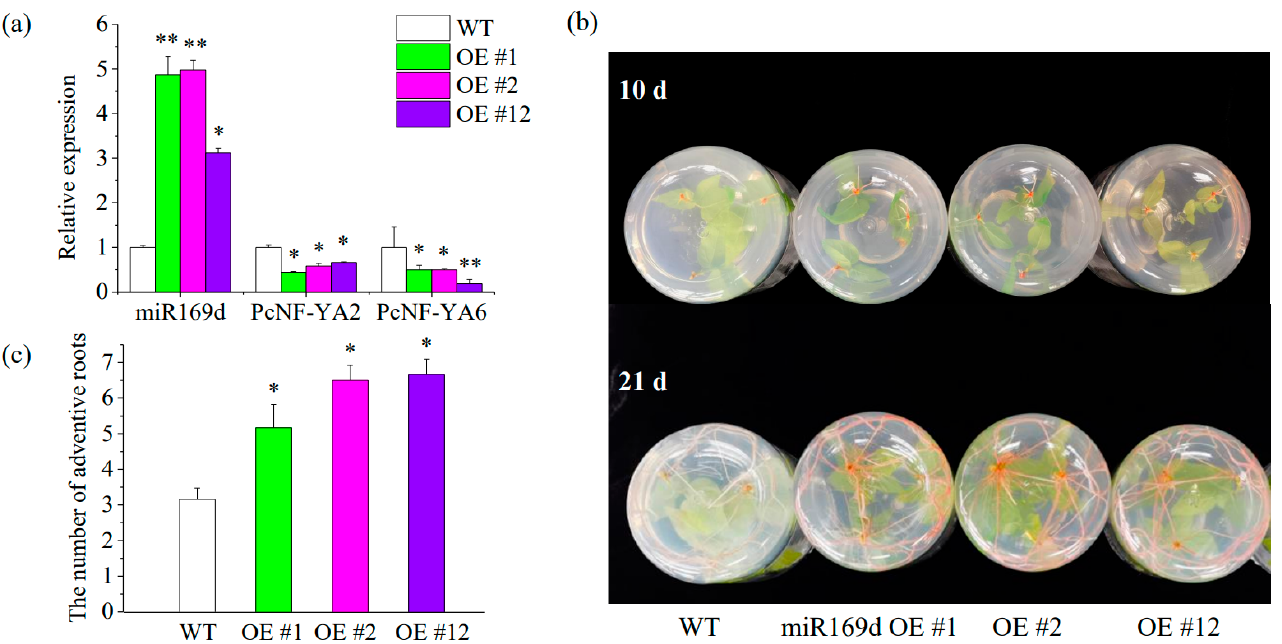
Figure 7. Phenotypic analysis of transgenic Populus with the miR169d gene under nitrate treatment. ( a ) Expression analysis of the miR169d and PcNF-YA2 / 6 genes with RT ‒ qPCR in transgenic Populus lines; ( b ) Root phenotypes of wild-type (WT) and transgenic Populus lines (miR169d OE #1, OE #2 and OE #12) after 10 and 21 days of nitrate treatment; ( c ) the adventitious root numbers of WT and transgenic Populus lines (miR169d OE #1, OE #2 and OE #12) after 10 and 21 days of nitrate treatment. P -values from one-way ANOVA for the different lines are indicated: *: p < 0.05; **: p < 0.01.